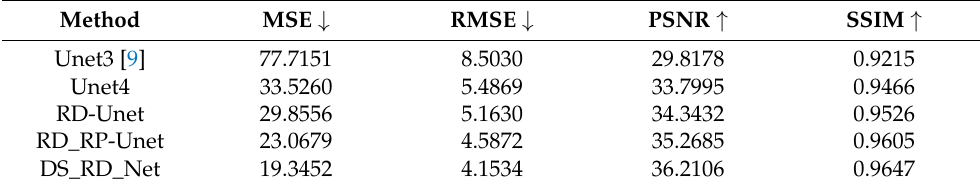
Table 1. Evaluation results of full-reference indicators on synthetic underwater